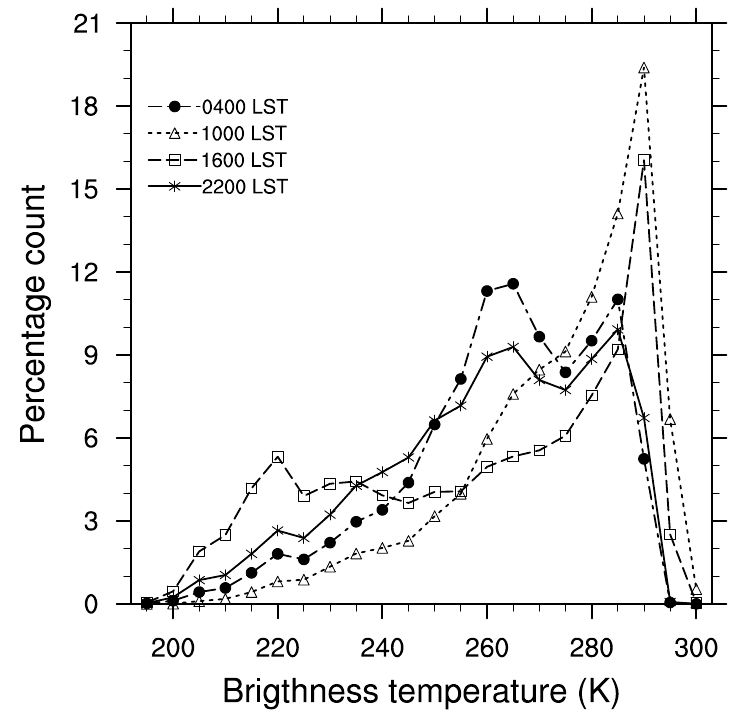
Figure 4. The evolution histogram of the percentage for which brightness temperature occurred within each 5 K interval, between 190 and 300 K during the daytime and the nighttime, over the whole region of the study for June–August